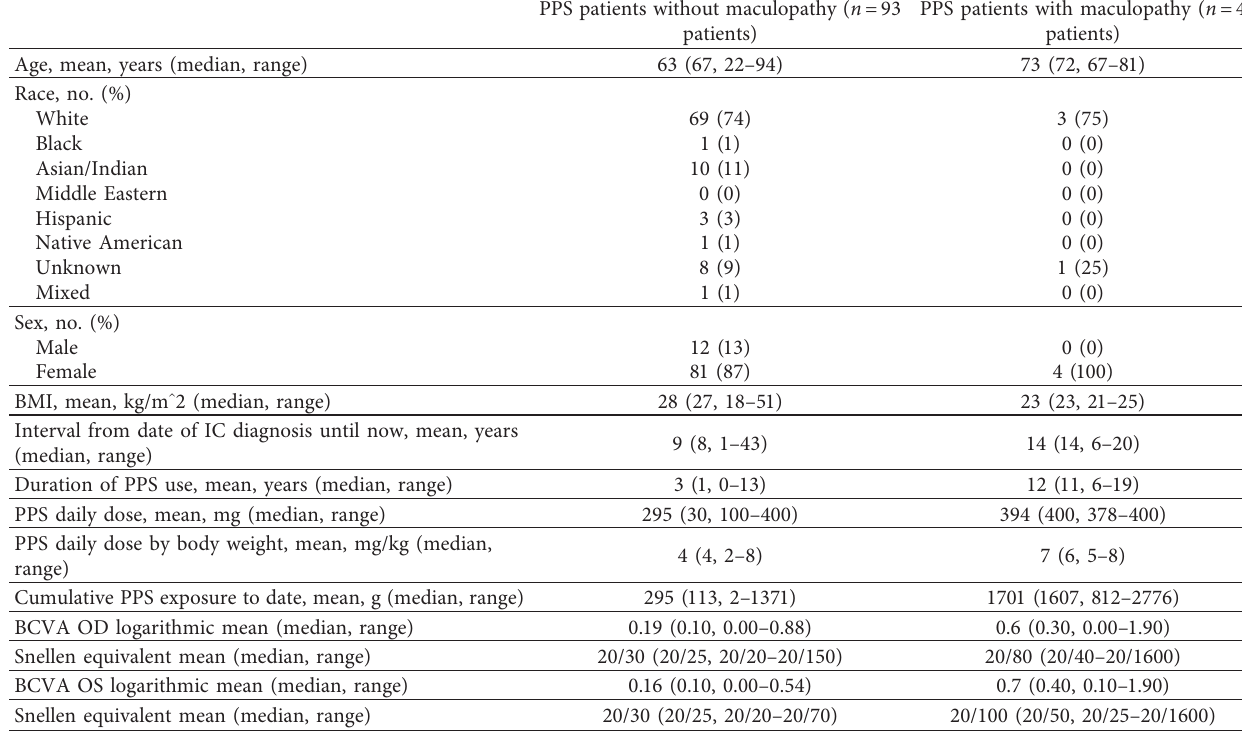
Table 1: Demographics and pentosan polysulfate sodium exposure history for patients who had an eye exam ( n � 96) and patient with maculopathy from outside referral ( n �